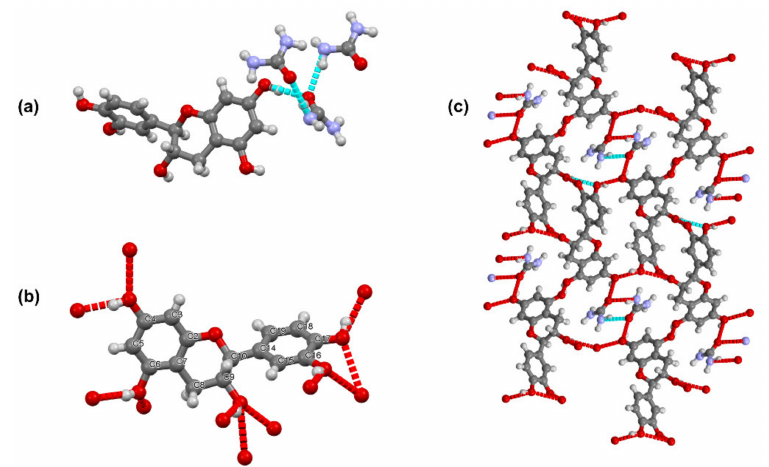
Figure 2. ( a ) Hydrogen bonding around a urea molecule in the UC cocrystal. ( b ) Hydrogen bonding around a catechin molecule in the cocrystal. ( c ) View along the a axis.